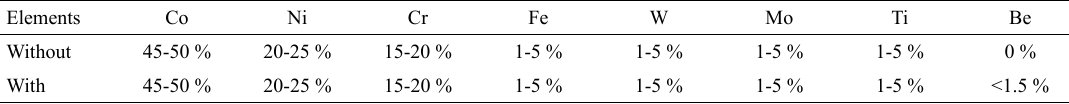
Table 1. Chemical composition and concentration range for the two grades of the examined Co-Ni-Cr based alloy.